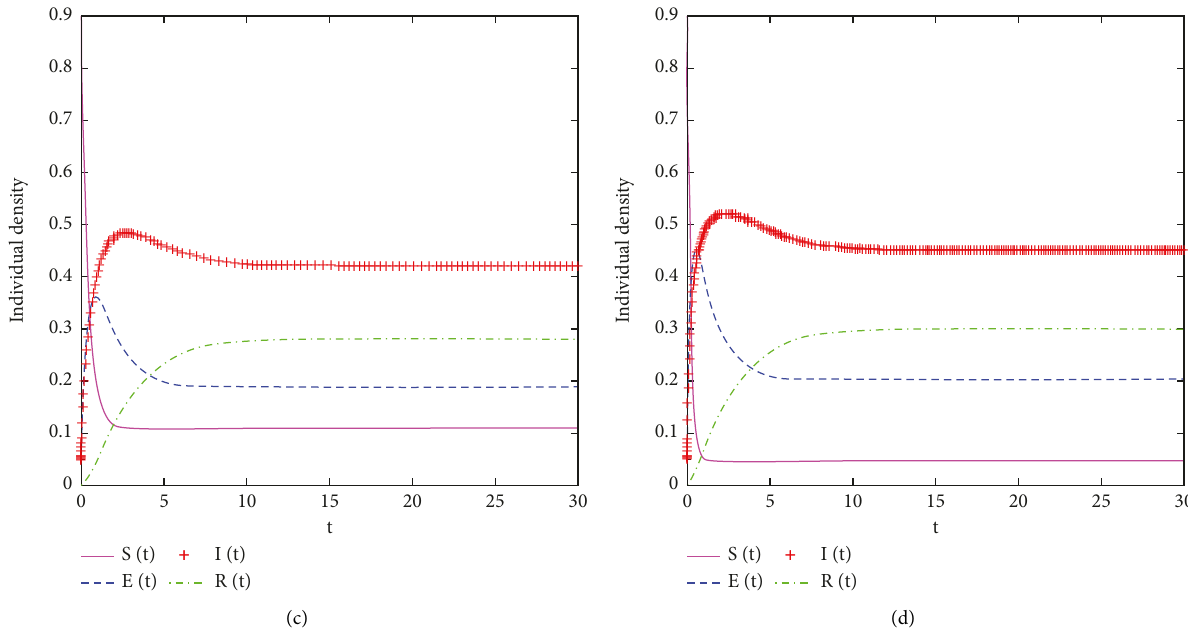
Figure 7: Simulation results of nodal enterprise degree on credit risk contagion. (a) k � 5. (b) k � 10. (c) k � 20. (d) k �